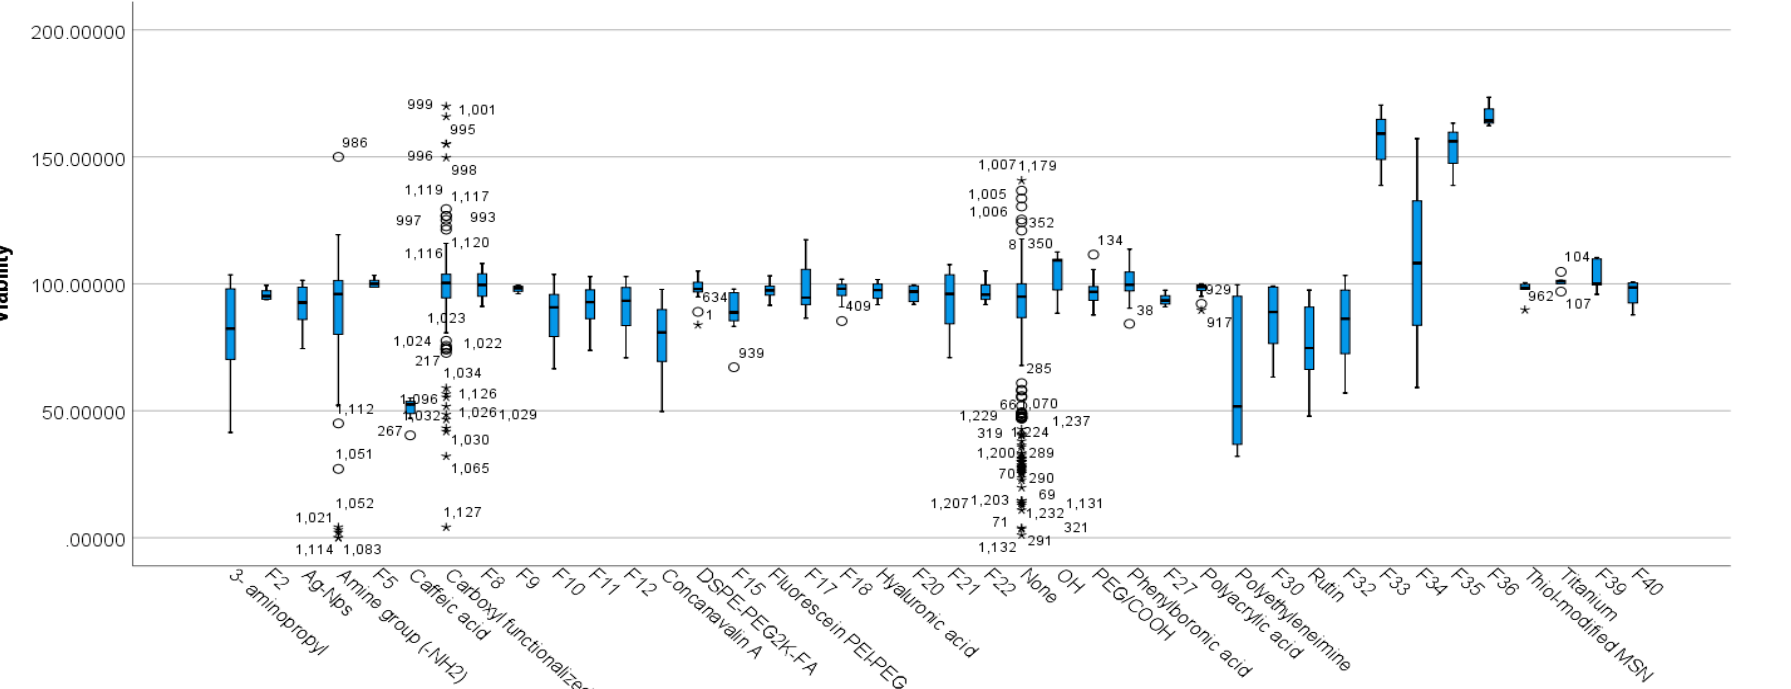
Figure 9. Distribution of viability across different functionalization types . Data points that are more than 1.5 box ‐ lengths from the edge of their (blue) box are classified by SPSS Statistics as outliers and are illustrated as circular dots. Any data points that are more than 3 box ‐ lengths away from the edge of their box are classified as extreme points (i.e., extreme outliers) and are illustrated with an asterisk (*). 4 ‐ nitroimidazole ‐β‐ cyclodextrin (NI ‐ CD) (F2), amino ‐ functionalised, disulfide bond ‐ bridged (F5), carboxyl groups and Amine ‐ peg2000 and biotinylated rituximab (F8), carboxyphenylboronic acid and sodium alginate (F9), Chlorodimethyloctadecylsilane (F10), Chlorodimethyloctadecylsilane and lipid membrane (F11), Chlorodimethyloctadecylsilane and lipid membrane and Arg ‐ Gly ‐ Asp (F12), fluorescein isothiocyanate (FITC) ‐ labeled (3 ‐ aminopropyl) ‐ trimethoxysilane (APTMS) conjugates and polydopamine (F15), Gadolinium and carboxyl group and low ‐ generation peptide dendron (F17), gadolinium ‐ based bovine serum albumin complex (BSA ‐ Gd) and hyaluronic acid (HA) (F18), hydrochloride dopamine (PDA), polyethylene glycol (PEG) (F20), hydrous, and non ‐ crystalline silica (F21), NH2 and Folic acid and arginine ‐ glycine ‐ aspartate (F22), Poly ‐ acrylic Acid and Folic acid (F27), polyethyleneimine ‐ folic acid (F30), succinylated ε‐ polylysine (F32), tetramethylrhodamine isothiocyanate and aminated (F33), tetramethylrhodamine isothiocyanate and aminated and polyethyleneimine (F34), tetramethylrhodamine isothiocyanate and aminated and polyethyleneimine and polyethyleneglycol (F35), tetramethylrhodamine isothiocyanate and aminated and polyethyleneimine and succinic acid (F36), tumor ‐ specific MUC1 antibody and fluorescein isothiocyanate (F39), upper critical solution temperature (UCST) thermally responsive polymer (F40).